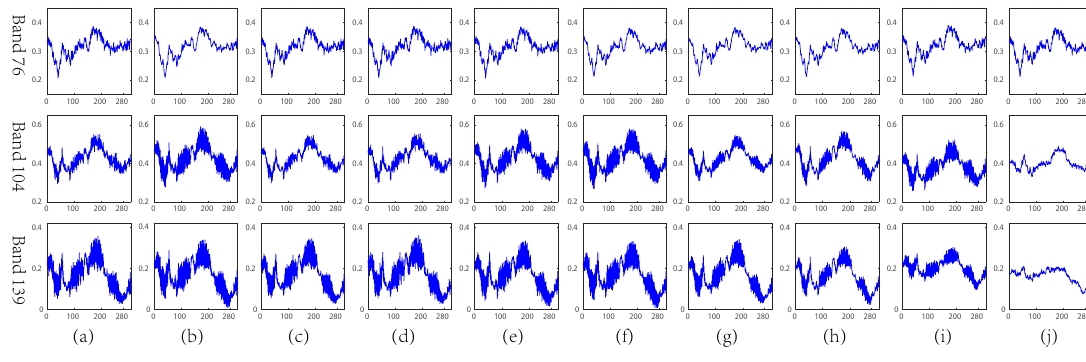
Figure 9. Vertical mean profiles of some typical bands of the Urban HSI dataset. From top to bottom: band 76 (top), band 104 (middle) and band 139 (down). From left to right: ( a ) Original HSI; ( b ) SVD; ( c ) BM4D; ( d ) TDL; ( e ) WNNM; ( f ) WSNM; ( g ) LRMR; ( h ) LRTV; ( i ) NMoG; ( j )